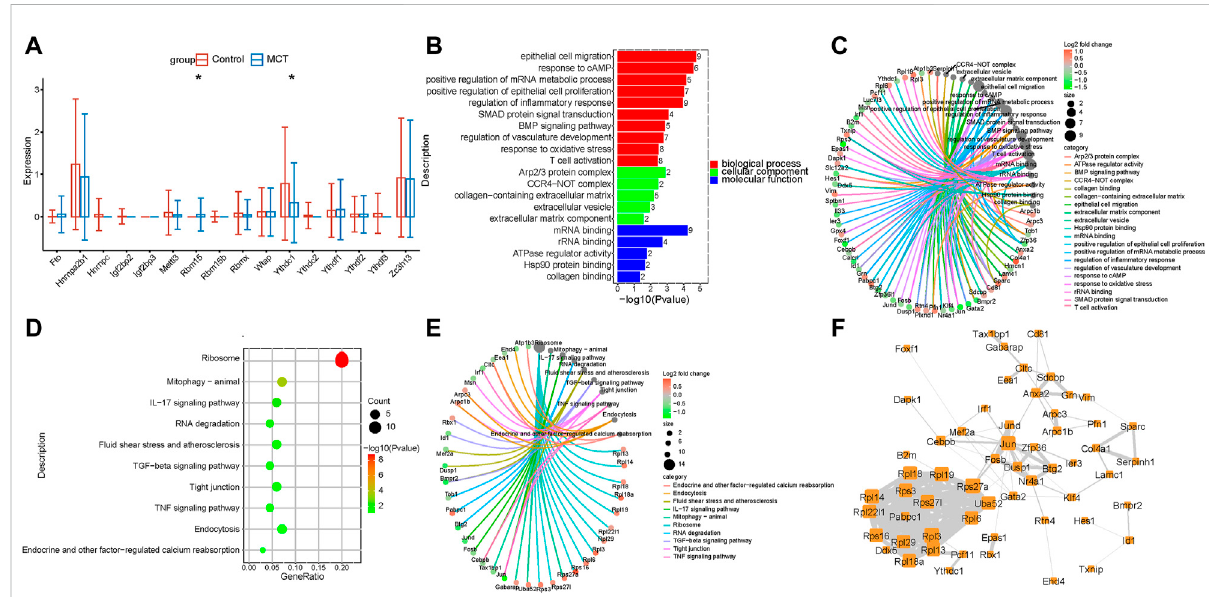
FIGURE 2 The expressionof m6A regulators was dysregulated in PAECs. (A) The m6A regulators were expressed differentiallyin PAECs. (B) GO analysis of thetargetgenesofYTHDC1thatoverlappedwiththeupregulatedDEGs. (C) Thegenesinvolvedintheenrichedpathwaysaredepicted. (D) TheKEGG analysis ofthetarget genesof YTHDC1 overlappedwith theupregulated DEGs. (E) The genesinvolved intheenrichedpathways are depicted. (F) The hub networks constructed based on the genes presented